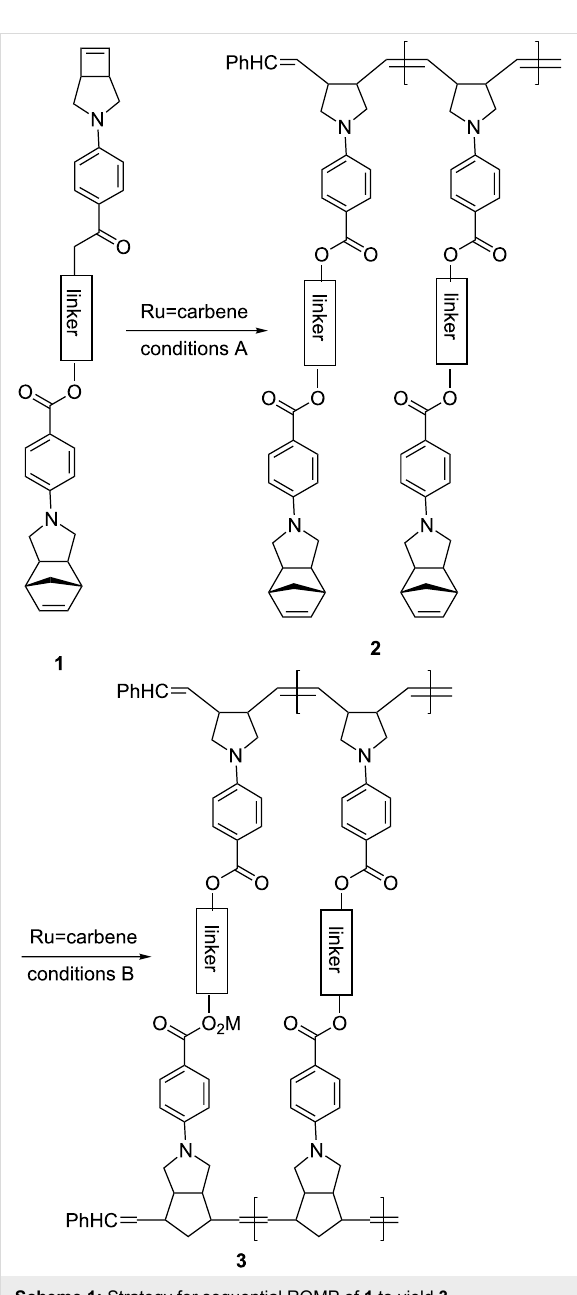
Scheme 1: Strategy for sequential ROMP of 1 to yield 3